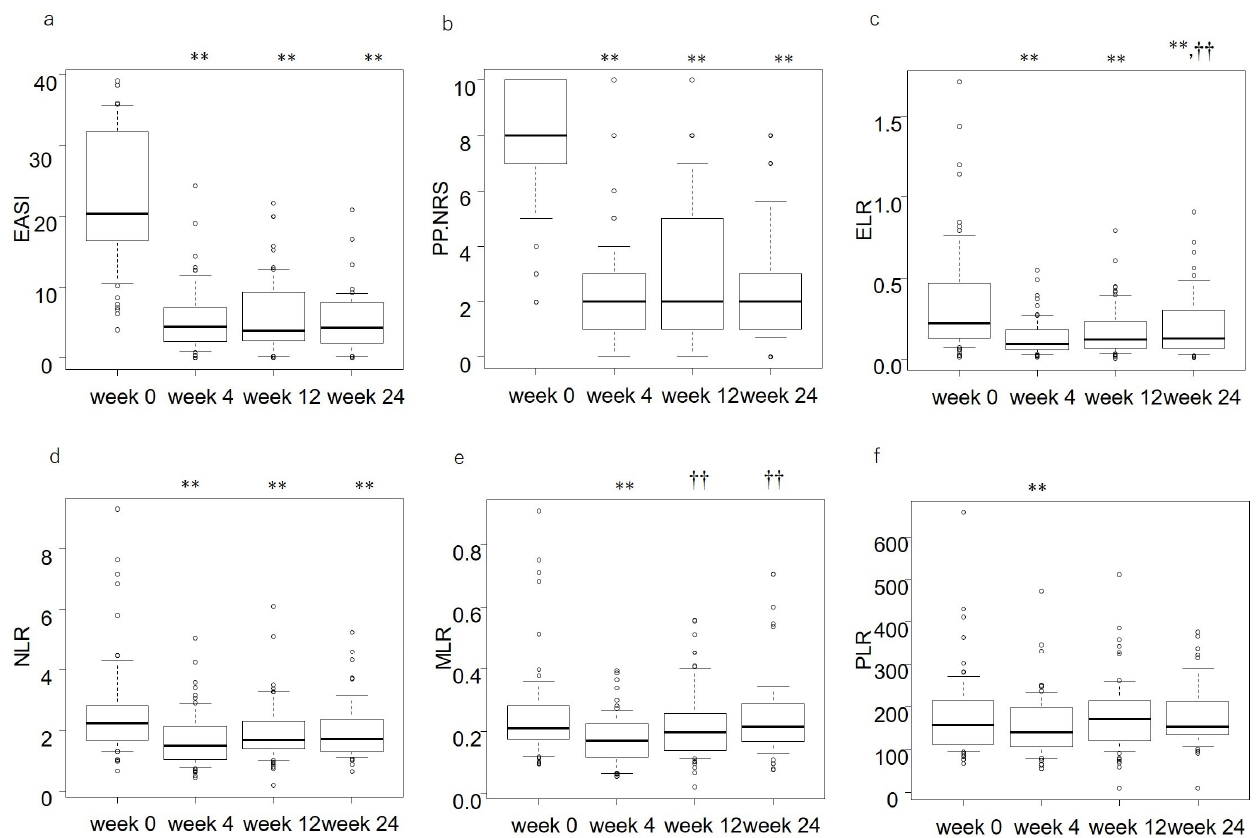
Figure 1. The transition of the eczema area and severity index (EASI) ( a ), peak pruritus-numerical rating scale (PP-NRS) ( b ), eosinophil-to-lymphocyte ratio (ELR) ( c ), neutrophil-to-lymphocyte ratio (NLR) ( d ), monocyte-to-lymphocyte ratio (MLR) ( e ), and platelet-to-lymphocyte ratio (PLR) ( f ) at weeks 0, 4, 12, or 24 of upadacitinib treatment in patients with atopic dermatitis ( n = 65). The thick lines in the boxes are medians, and the boxes are interquartile ranges. ** p < 0.01 versus the value of week 0; †† p < 0.01 versus the value of week 4, analyzed by Friedman’s test.